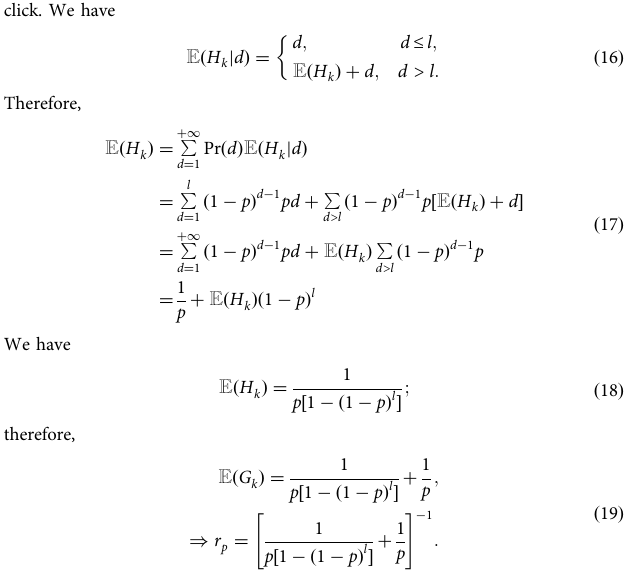
Based on the intensities μ i and μ j on the i -th and j -th location, Alice (or Bob) assign the basis to be either X , Z , ‘ 0 ’ , or ‘ discard ’ .